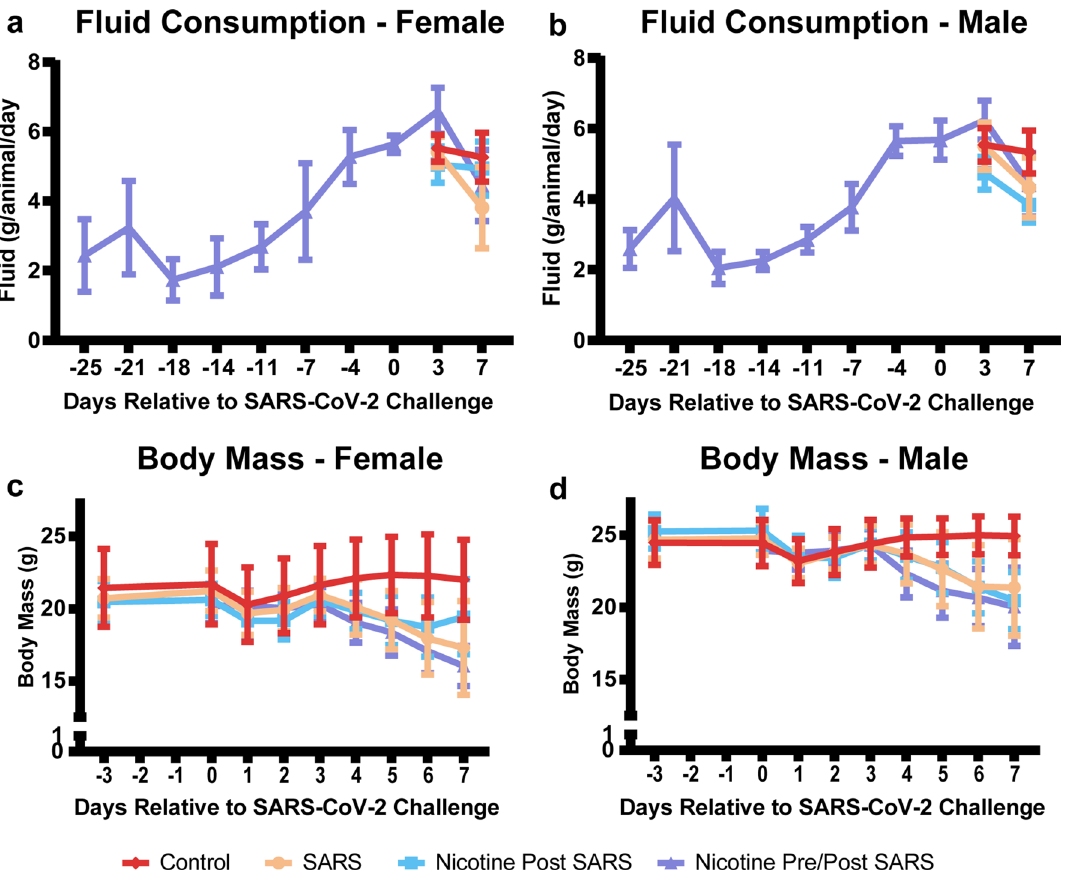
Figure 2. Body mass and fluid consumption. ( a , b ) Fluid consumption of mice across time. Fluid was only measured in Nicotine Pre/Post Nicotine prior to the SARS-CoV-2 challenge. Data indicated mice did not take to the 200 µg/ml nicotine dosage and required hydrating gel placed on the sippers to encourage drinking. Due to this observation, mice in Nicotine Post SARS were given two days of 100 µg/ml after the SARS-CoV-2 challenge to acclimate before increasing the dosage to 200 µg/ml for the remainder of the study. ( c , d ) Body mass of mice across the study timeline. Stats were not employed due to missing data from mice that did not survive until seven days after the SARS-CoV-2 challenge. Data are represented by means and standard